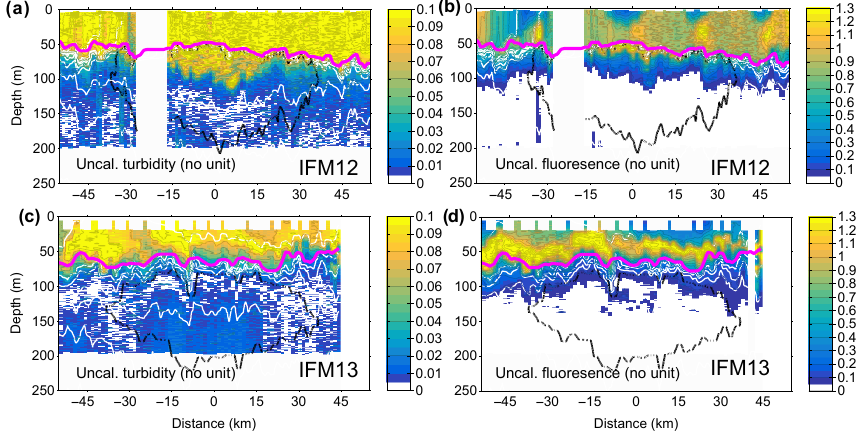
Figure 6. Uncalibrated turbidity (a, c) and chlorophyll-fluorescence (b, d) data from the glider IFM12 survey (a, b) and glider IFM13 survey (c, d) . The magenta line denotes the base of the mixed layer; the broken black line is the extent of the low oxygen core (oxygen < 40µmolkg − 1